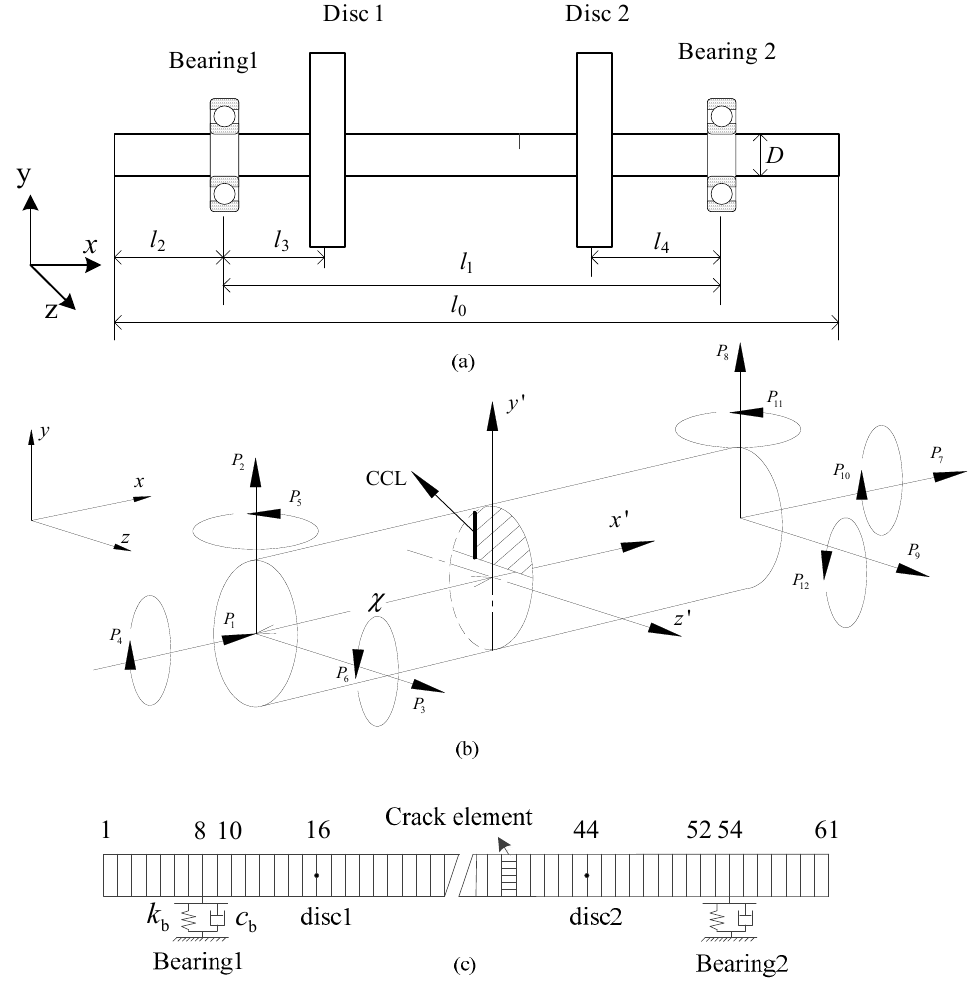
Figure 1. Models of a cracked rotor-bearing system. ( a ) The cracked two discs rotor-bearing system; ( b ) the cracked shaft element; ( c ) the finite beam element